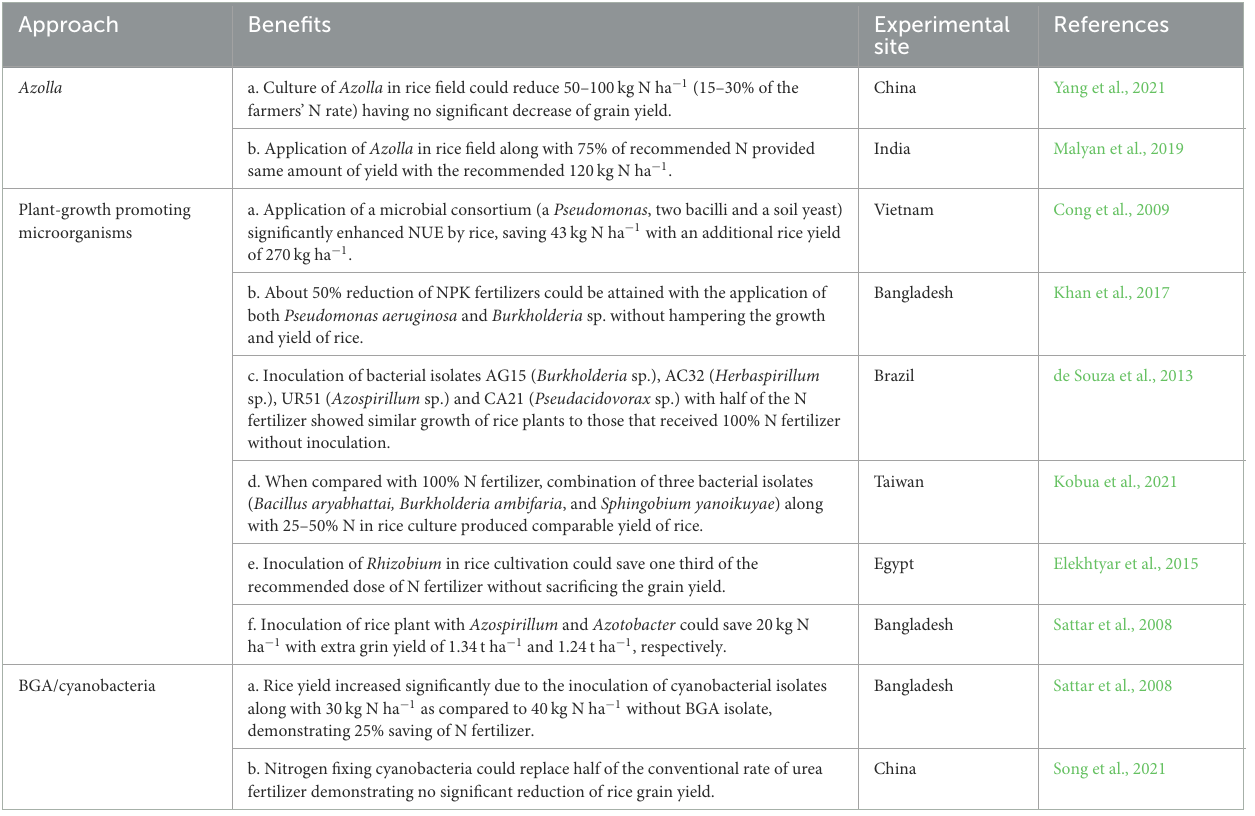
TABLE 5 Reduction of inorganic nitrogen in rice cultivation through biological